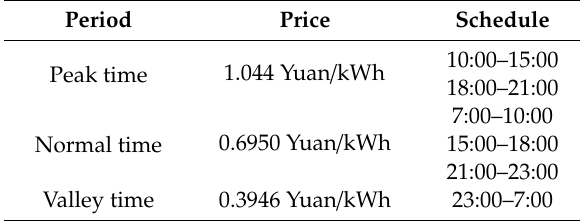
Table 4. Particle swarm optimization (PSO) parameters.